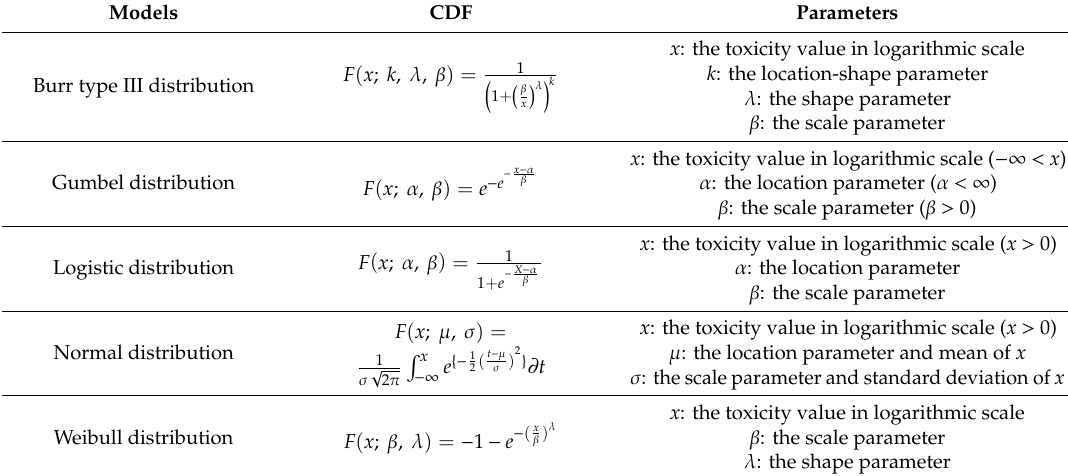
Table 3. Models and cumulative distribution function (CDF) for species sensitivity distributions (SSDs)